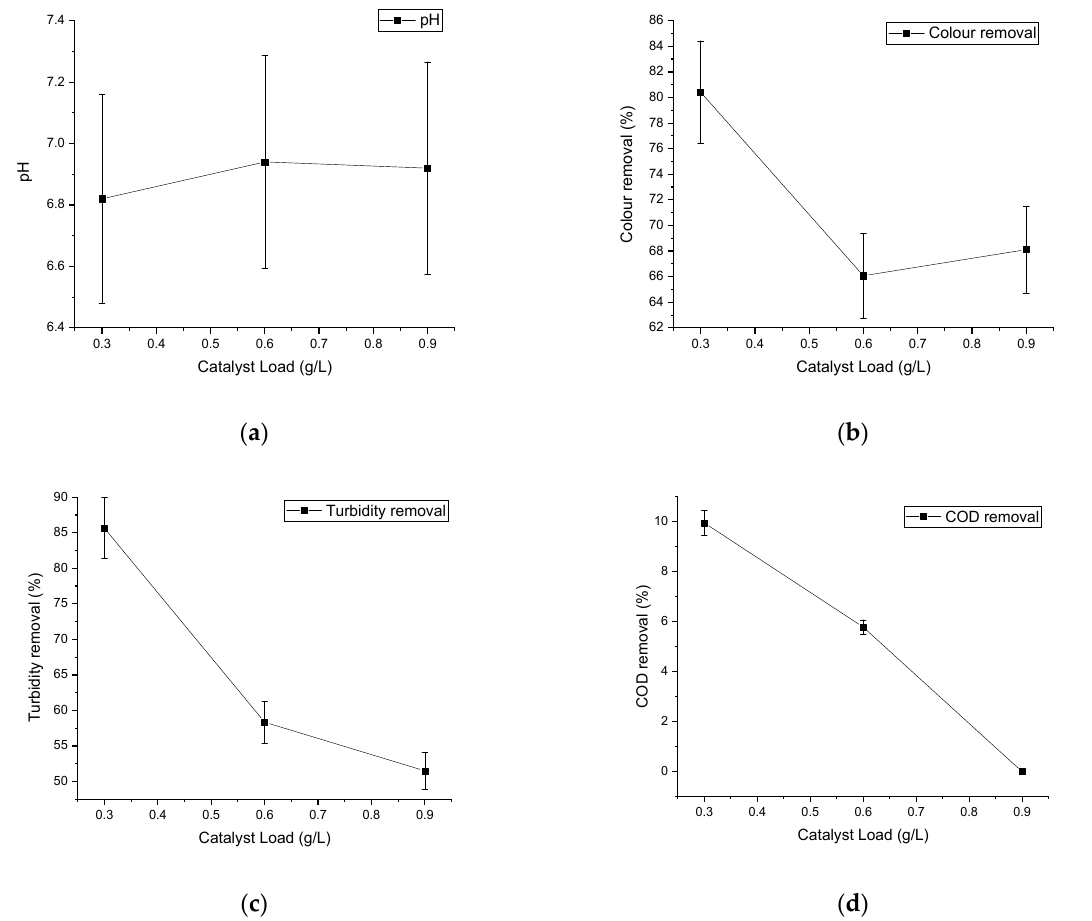
Figure 4. Trends of the effect of catalyst load on photocatalysis treatment parameters: ( a ) The effect of catalyst load on pH; ( b ) The effect of catalyst load on colour removal; ( c ) The effect of catalyst load on turbidity removal ( d ) The effect of catalyst load on COD removal (reaction time of 60 min and mixing speed of 60 rpm).